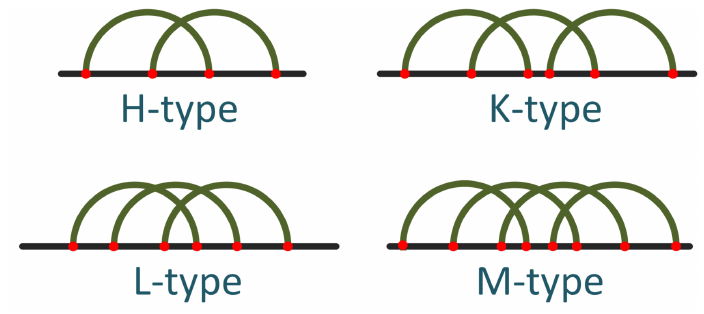
Figure 1. The most common types of pseudoknots (after [42]).